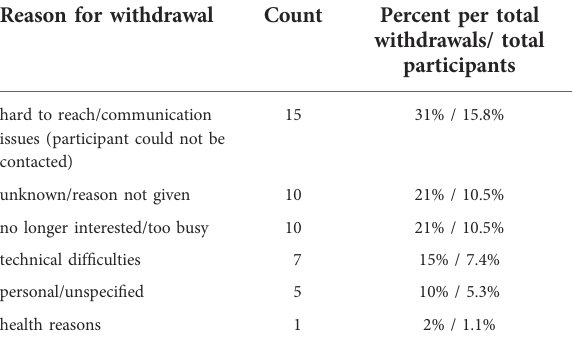
TABLE 3 Reasons for study